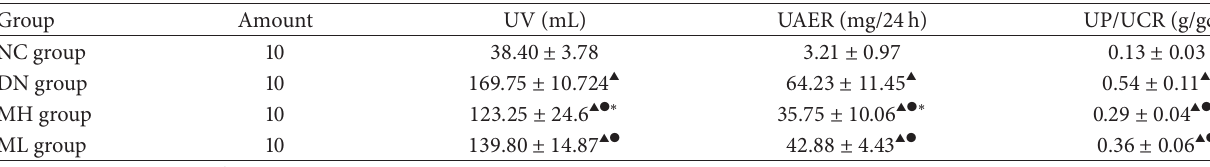
Table 2: Results of UV, UAER, and Up/Ucr ( 𝑥 ± 𝑠 ). The values of UV, UAER, and Up/Ucr were greater in the experimental groups compared with the NC group, and were the highest in the DN group. However, these values decreased in the MH and ML groups compared with the DN group, with a more pronounced decrease in the MH group compared with the ML group.